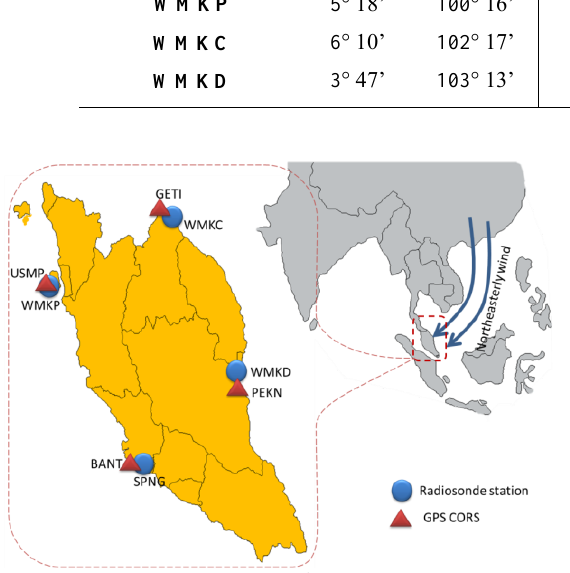
Figure 1. The spatial location of radiosonde station and GPS CORS in Peninsular Malaysia. Right figure shows the northeasterly wind direction flow out from northern hemisphere contribute the variability in T S at east coast region (Figure is adapted accordingly Tangang et al., (2008)).